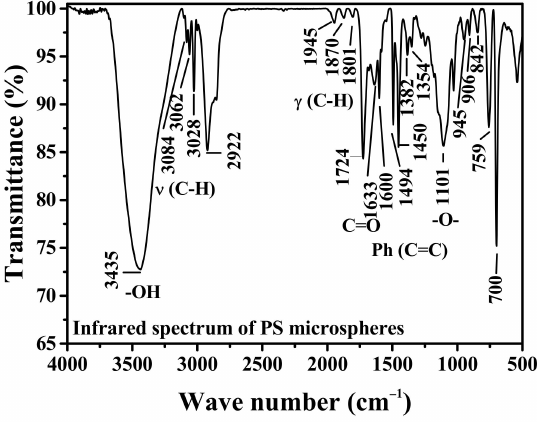
Figure 5. Infrared spectrum of PS microspheres.